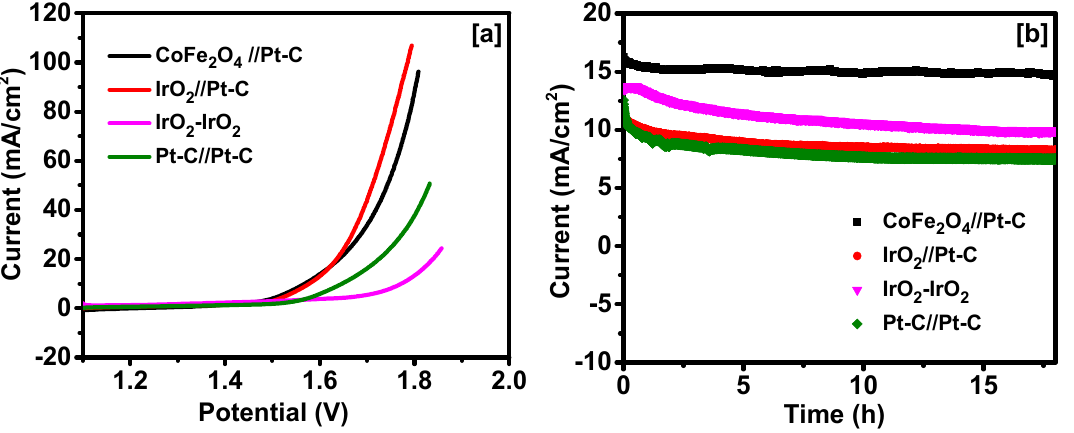
Figure. 6. ( a ) Polarization and ( b ) chronoamperometry plots for overall water splitting of a two-electrode electrolyzer.